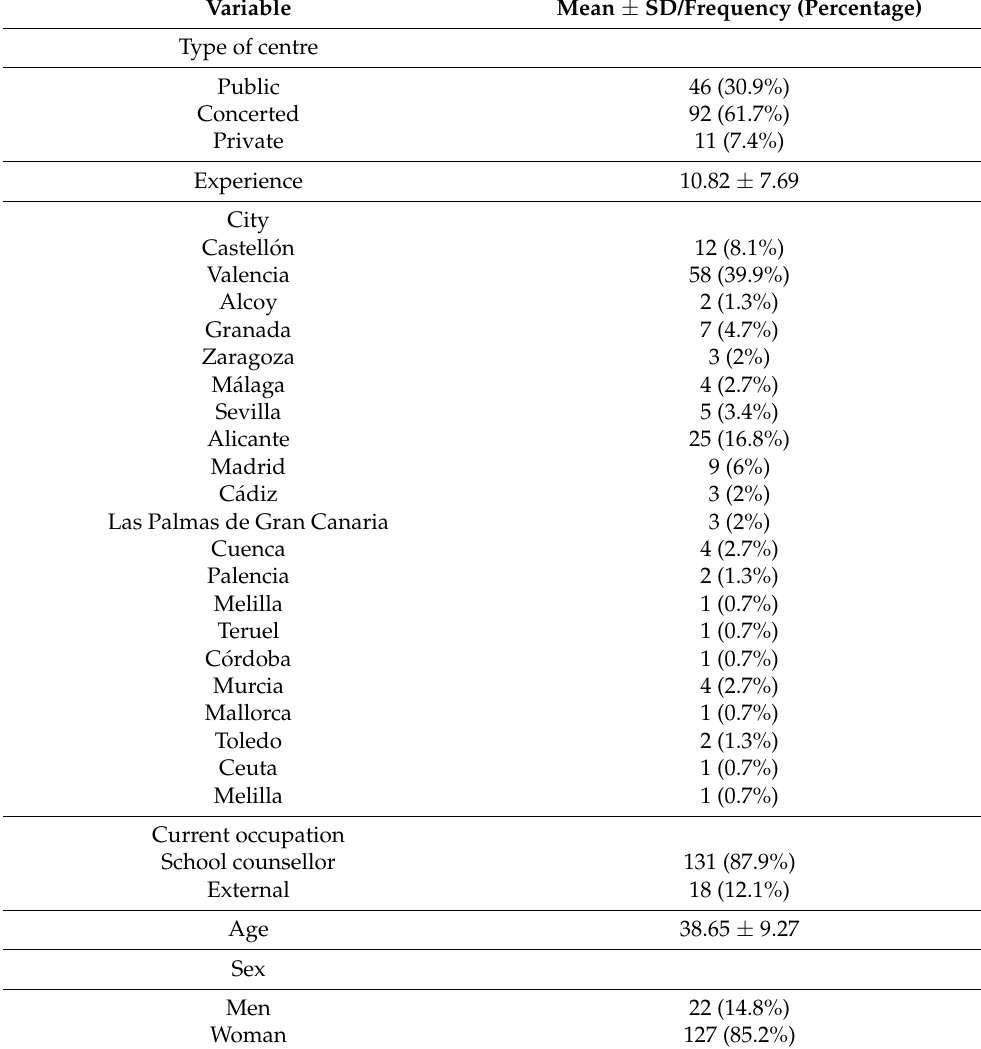
Table 1. Socio-demographic characteristics of the